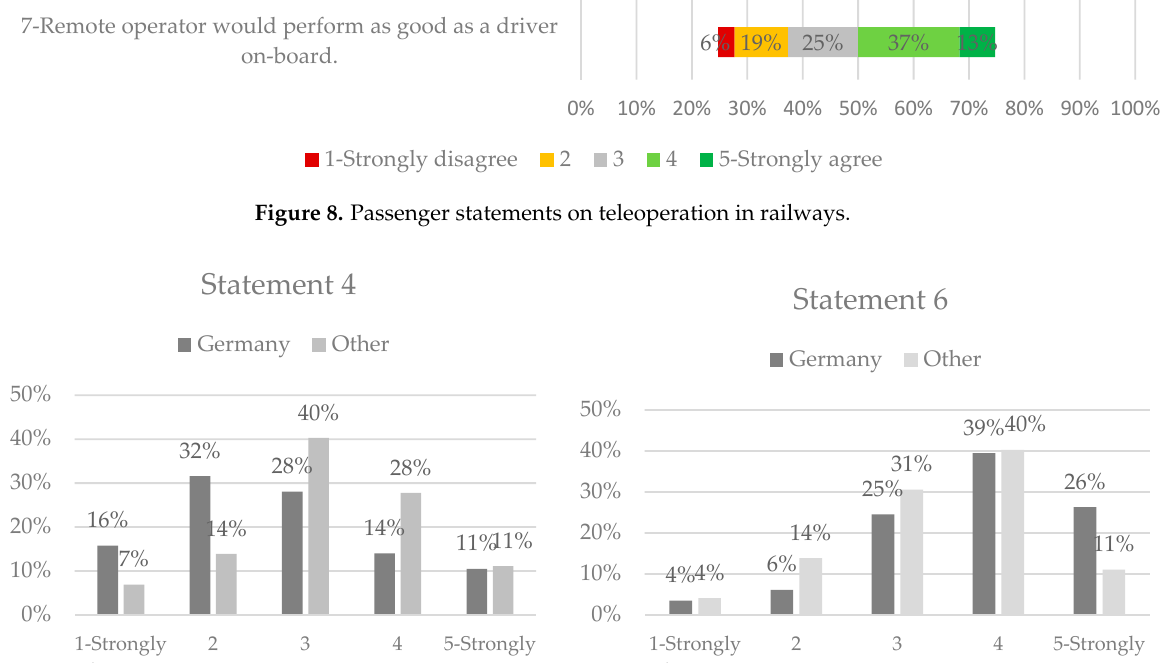
country of residence at 95% confidence level for statement 4 (H = 9.035, n = 114-72, p =